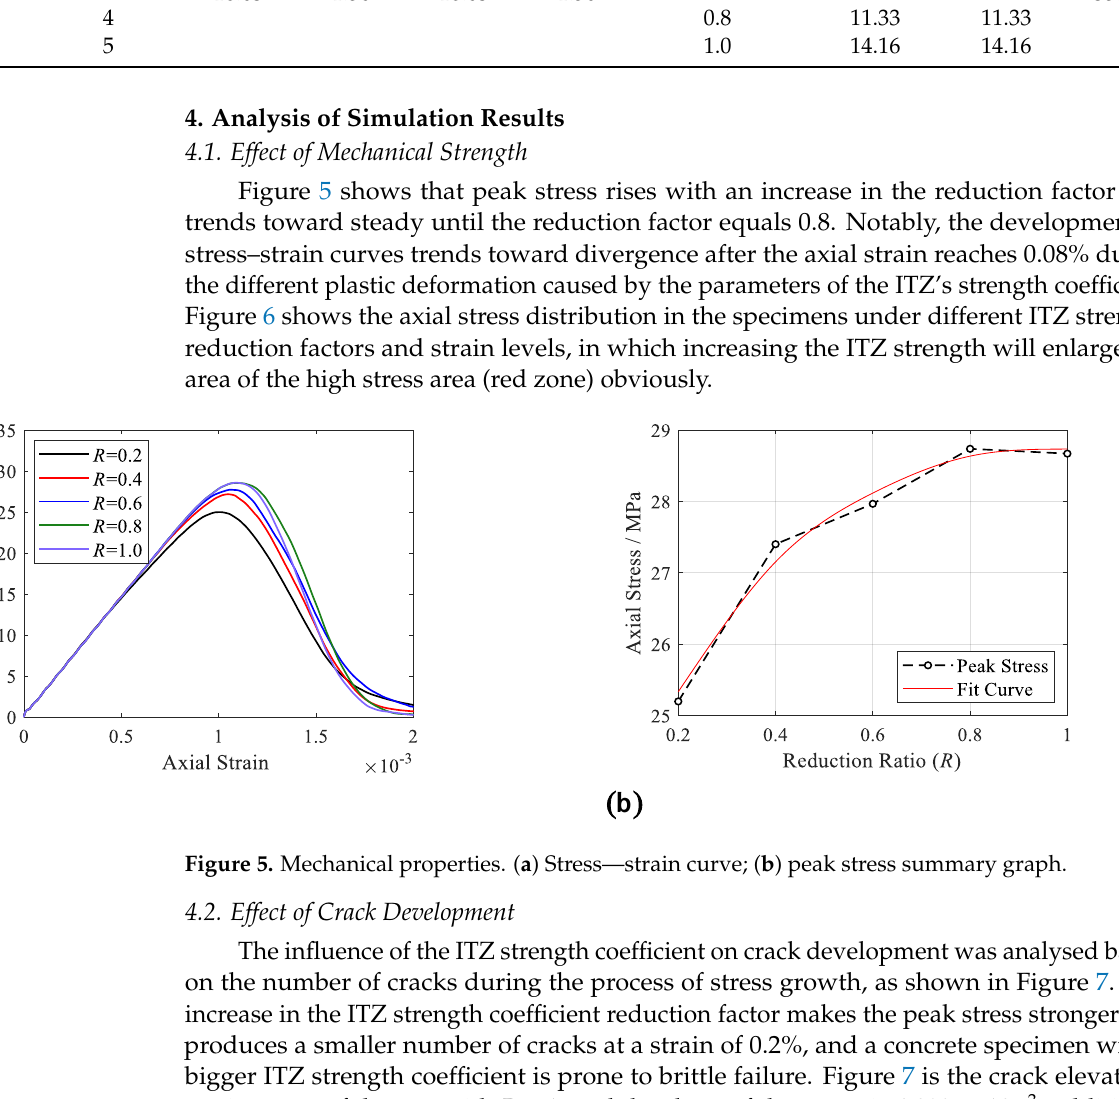
Figure 6. Stress field with different strain state. 4.2. Effect of Crack Development The influence of the ITZ strength coefficient on crack development was analysed based on the number of cracks during the process of stress growth, as shown in Figure 7. The increase in the ITZ strength coefficient reduction factor makes the peak stress stronger and produces a smaller number of cracks at a strain of 0.2%, and a concrete specimen with a bigger ITZ strength coefficient is prone to brittle failure. Figure 7 is the crack elevation – strain curve of the test with R = 1, and the slope of the curve is 4.092 × 10 −3 ; additional statistical analysis of crack elevation was also performed. The proportions of the different crack elevations inside the concrete specimen at a strain of 0.2% are listed in Figure 7c, wherein the slope of the curve reveals the distribution characteristic of the cracks. The corresponding slope becomes steeper with the increase in the reduction factor, which re- flects the horizontal cracks gradually transforming into vertical cracks.